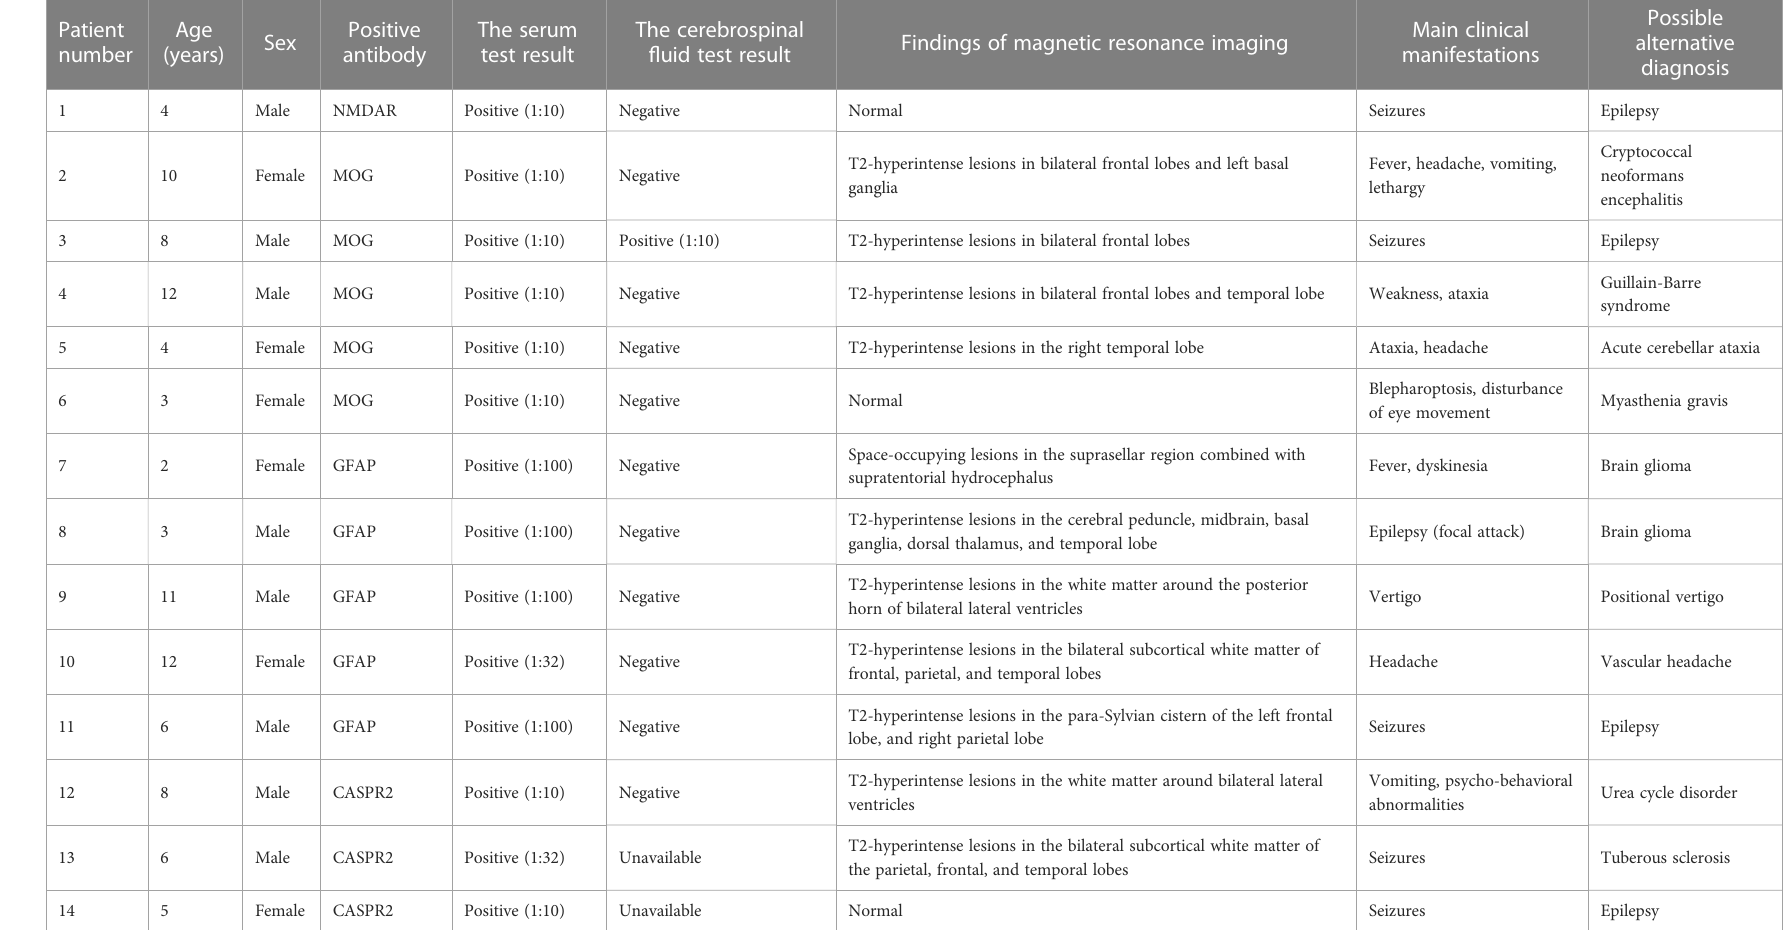
TABLE 1 The excluded pediatric patients with false-positive results of anti-neural antibody testing for suspected antibody-mediated CNS autoimmune